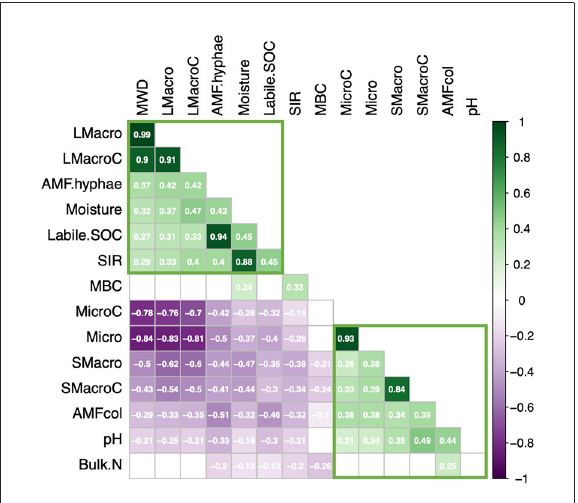
FIGURE3 Summary of Spearman rank ( r s ) correlation analyses between WSA and aggregate OC and significant edaphic correlates ( p > 0.05). Values within each square denote the value of r s with positive correlations in green and negative correlations in purple. Color intensity is proportional to the correlation coefficient. Non-significant correlations are left blank. LMacro,